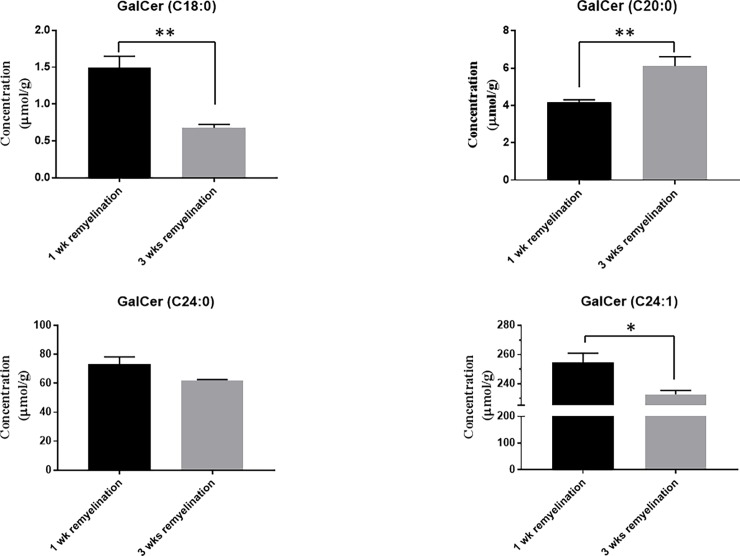
The levels of individual species of galactosylceramides, GalCer, during remyelination in the presence of vitamin K, were determined by mass spectrometry.The remyelination took place for either 1 week or 3 weeks in the presence of vitamin K. The levels of brain GalCer (C18:0) (A), GalCer (C20:0) (B), GalCer (C24:0) (C), and GalCer (C24:1) (D) were measured in the brain samples of mice that remyelinated for either 1 week or 3 weeks while receiving vitamin K injections as described under the Materials and Methods section. n = 4 mice per group, and concentrations are expressed as mean ± SEM. *P < 0.05, **P < 0.01. Please see the text for the actual P-values.